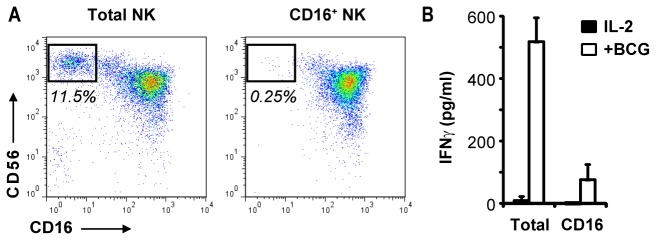
CD56bright NK cell subset constitutes the main source of
IFN-γ following mycobacterial exposure.A) CD56 versus CD16 FACS plot analysis of the total population of NK
cells (left plot) isolated from the blood of a healthy human donor in
comparison to CD16+ isolated NK cells from the same donor
(right plot). B) Bar graph showing the production of IFN-γ after 72h of
exposure with M.
bovis BCG (MOI 1:4) from total NK cells
in comparison to an equal number of autologous CD16+ NK cells
(n=2, mean +/- SD of technical replicates).